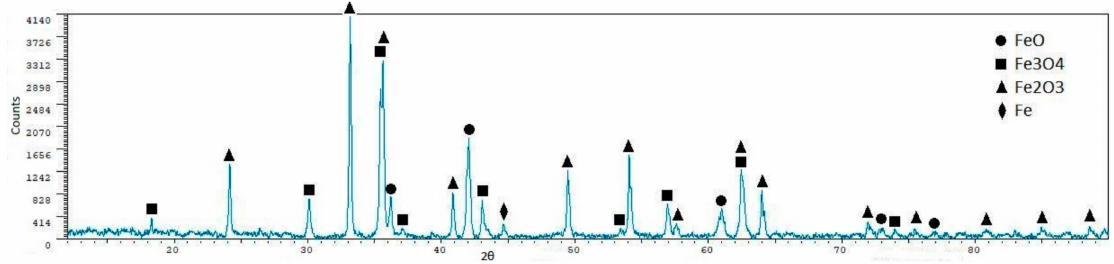
Figure 15. X-ray diffraction diagram for the sample